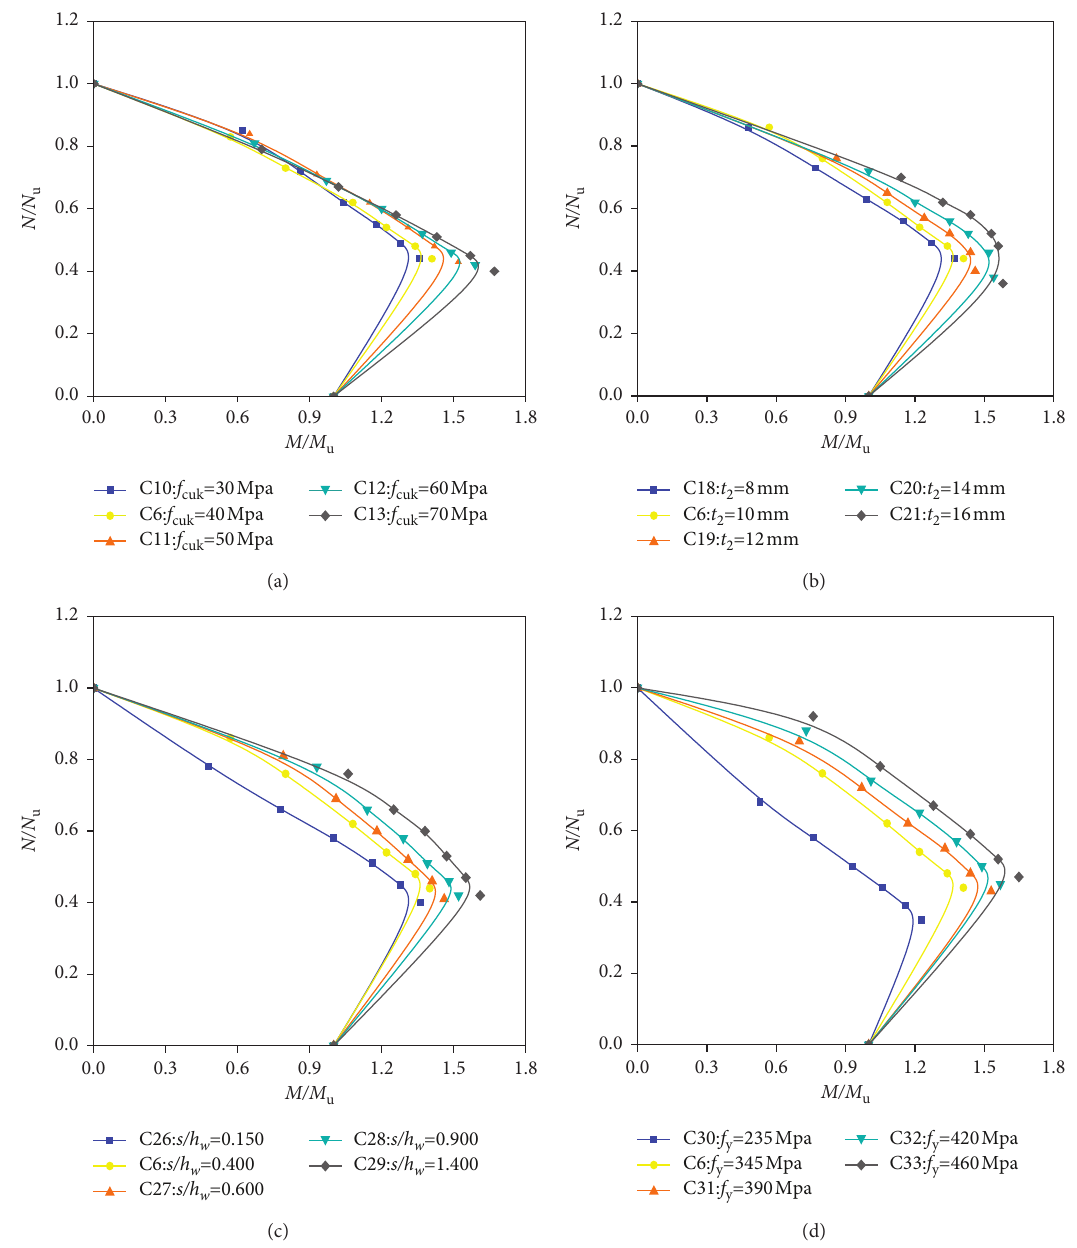
Figure 11: Comparisons of N / N u - M / M u curves of STHCCs with different parameters. (a) f cuk . (b) t 2 . (c) s / h w . (d) f y